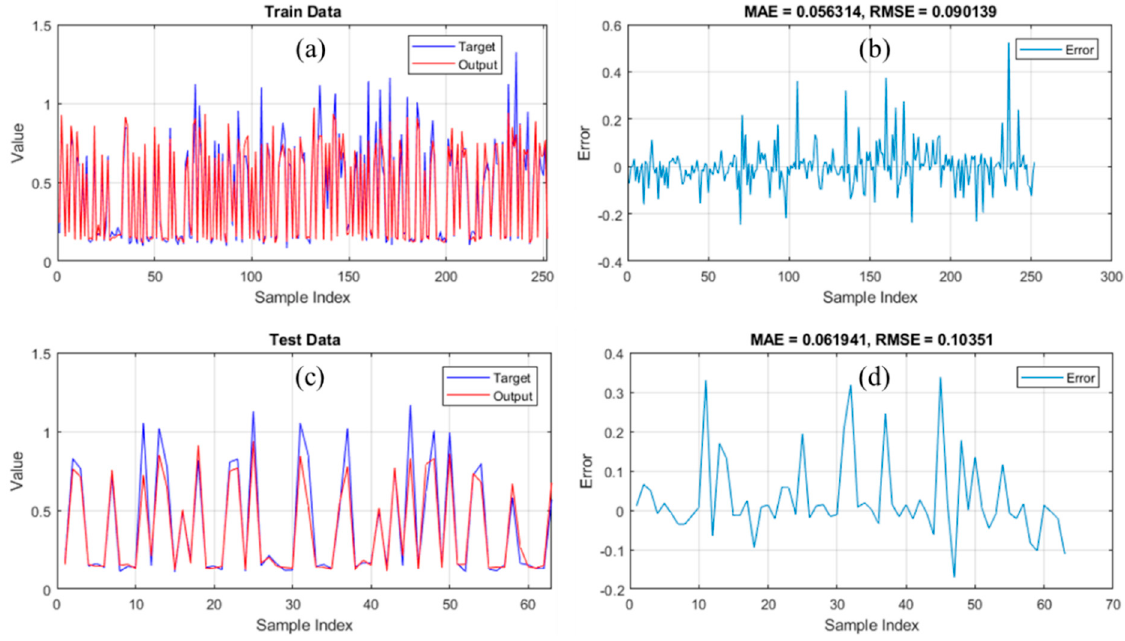
Figure 7. The ALO–ANN results for the ( a , b ) training and ( c , d ) testing data.